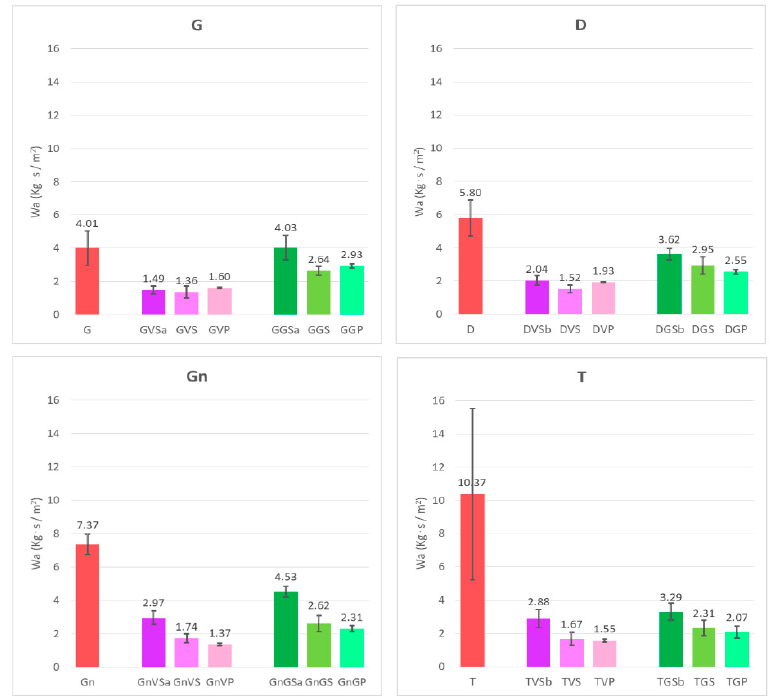
Figure 7. Water absorption ( W a, kg s / m 2 ) of the uncoated stone and the surfaces coated with either the sacrificial or permanent anti-graffiti product after being cleaned with the respective products. n = 3. Standard deviations are also shown. Check Table 1 for sample labeling .